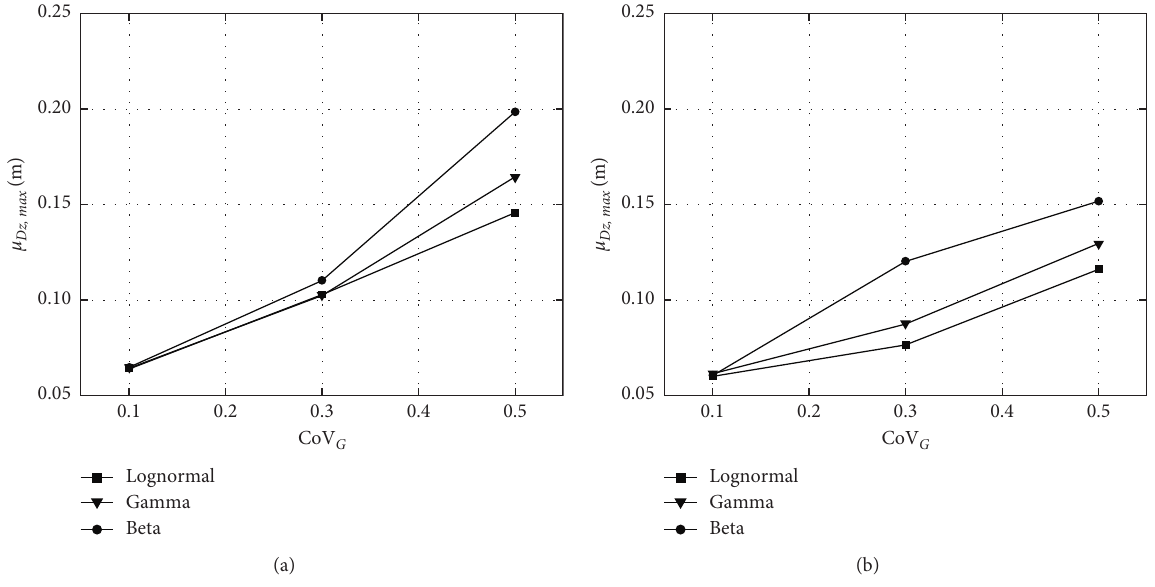
Figure 9: Variation of μ